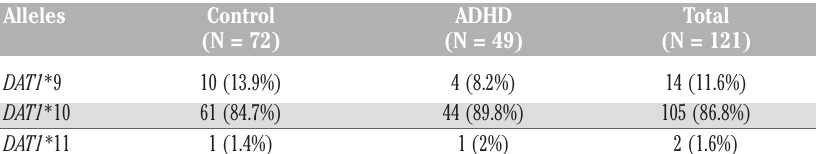
Table 2. Frequency of the DAT1